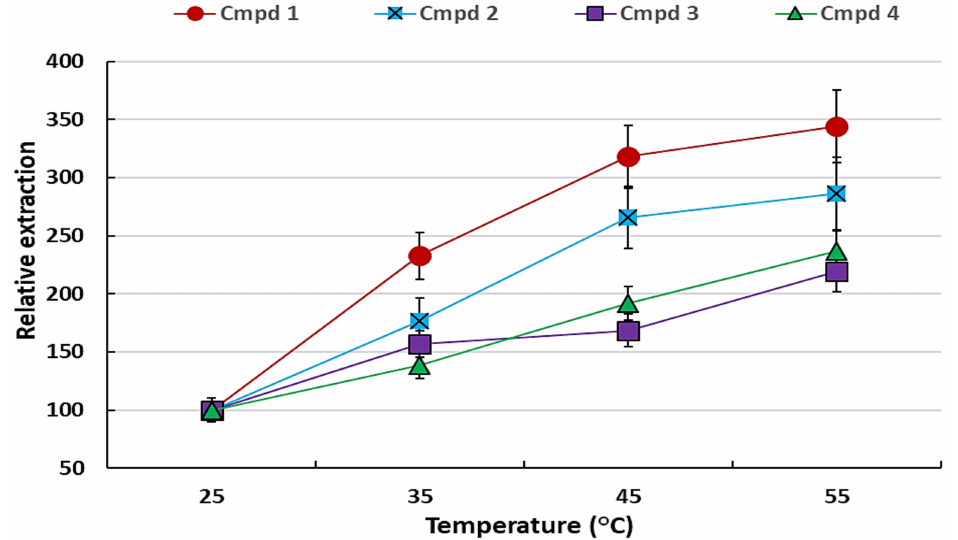
Figure 3. The effect of temperature on the headspace SDME of the VOCs using 2 µ L heptade- cane and 10 min equilibration relative to 25 ◦ C. The error bars indicate the standard deviation for n = 3